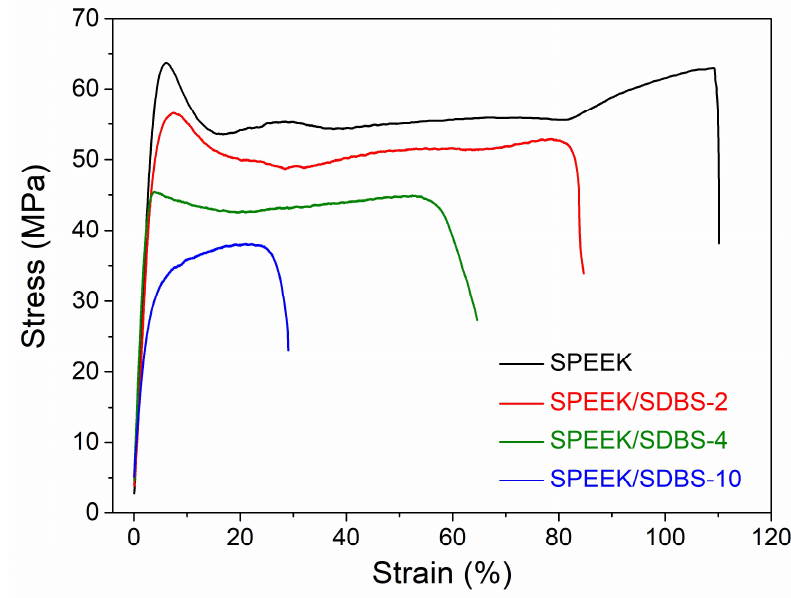
Figure 8. Stress–strain curves of a SPEEK membrane and SPEEK/SDBS membranes with SDBS contents of 2 wt %, 4 wt %, and 10 wt